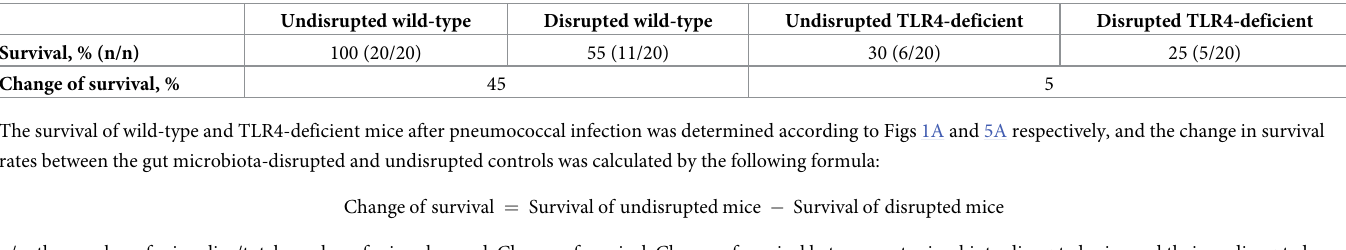
trols after pneumococcal infection. Considering the decreased pulmonary bacterial clearance